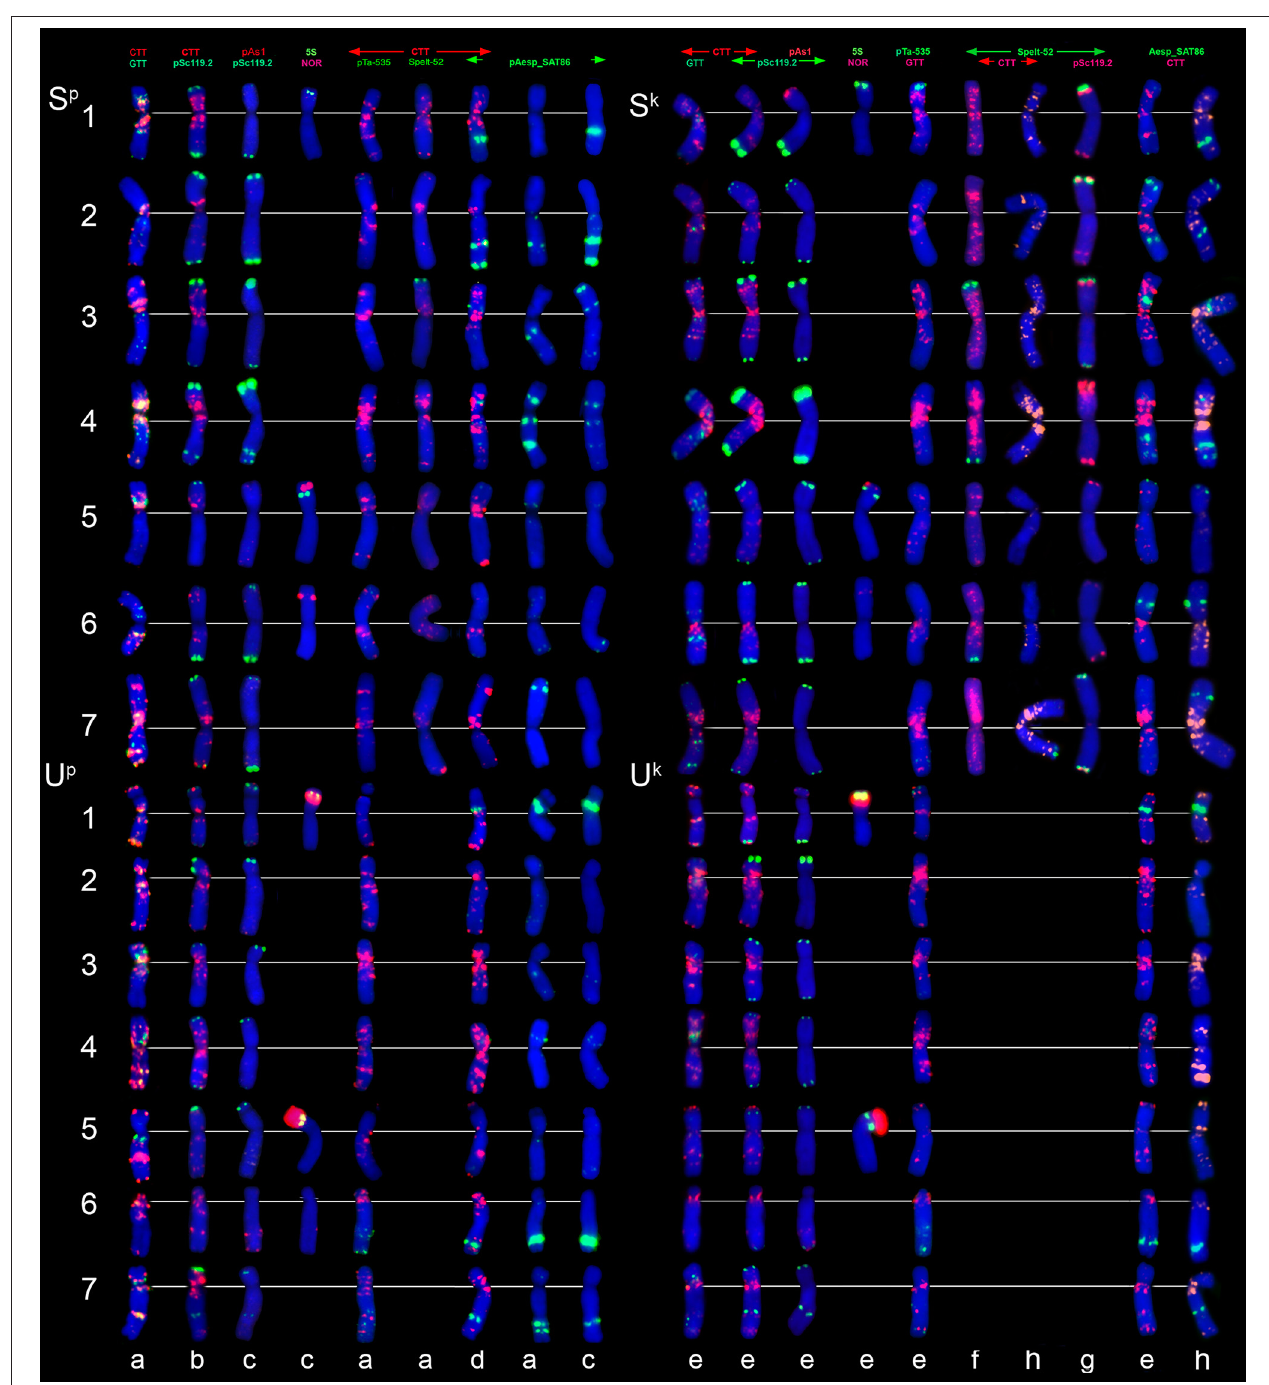
FIGURE 7 | Distribution of repetitive DNA families on chromosomes of Ae. peregrina left side and Ae. kotschyi (right side of the figure): (a) , C11 (Nahal Mearot, Israel); (b) , C8 (Haifa, Carmel, Israel); (c) , K-61; (d) , C9 (Keshon, Israel); (e) , TA2206; (f) , K-91; (g) , hybrid Ae. umbellulata TU04 × Ae. sharonensis TH02; (h) , K-2905. Probe combinations are given on the top; signal color corresponds to probe name. The S-genome chromosomes are shown on the top, the U-genome–on the bottom part of the figure.